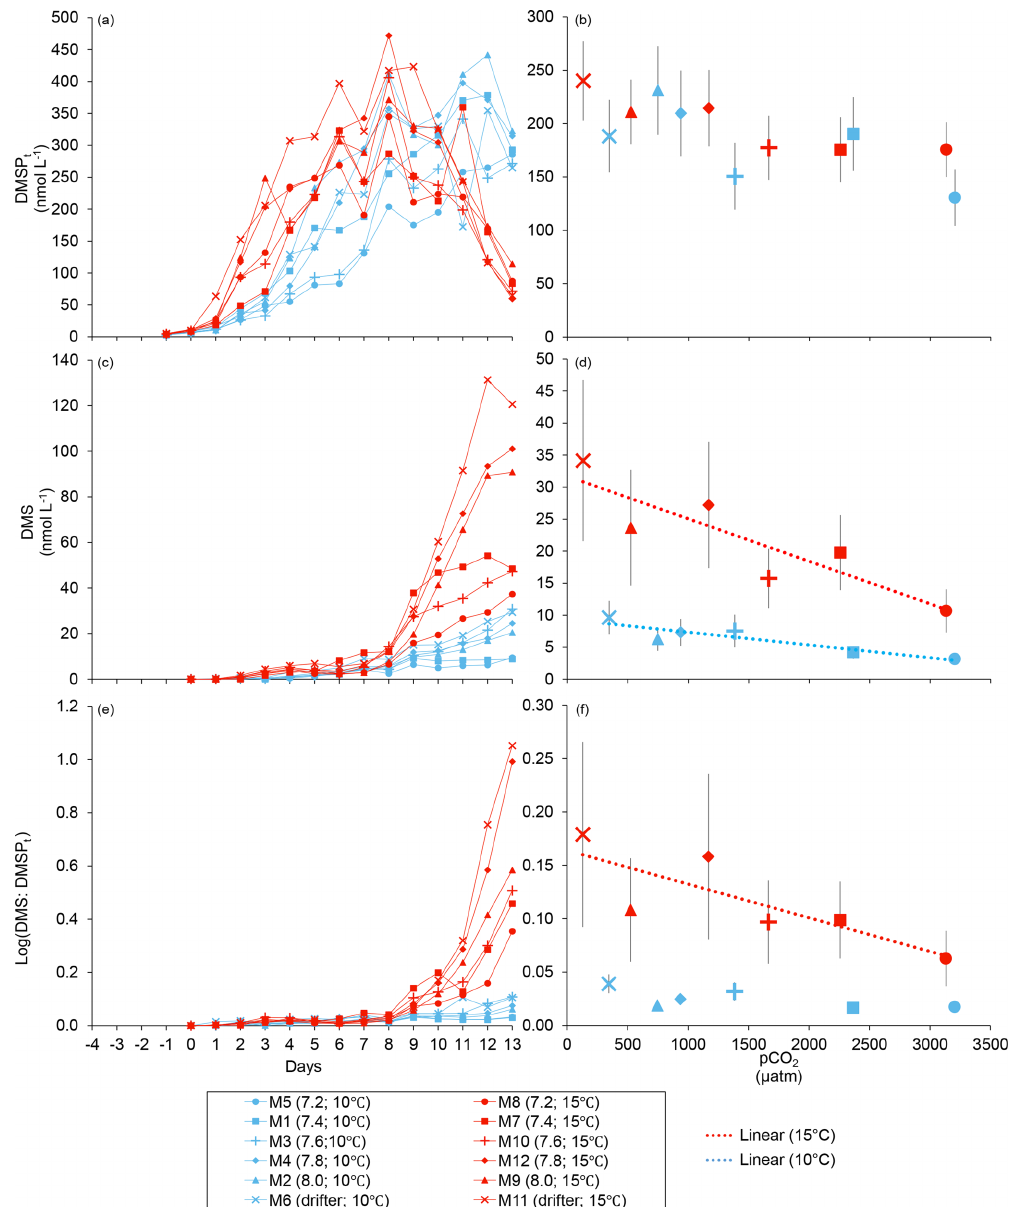
Figure 3. Temporal variations and averages over the course of the experiment (day 0 to day 13) for (a–b) DMSP t , (c–d) DMS, and (e–f) the natural logarithm of the DMS : DMSP t ratio. For symbol attribution to treatments, see the